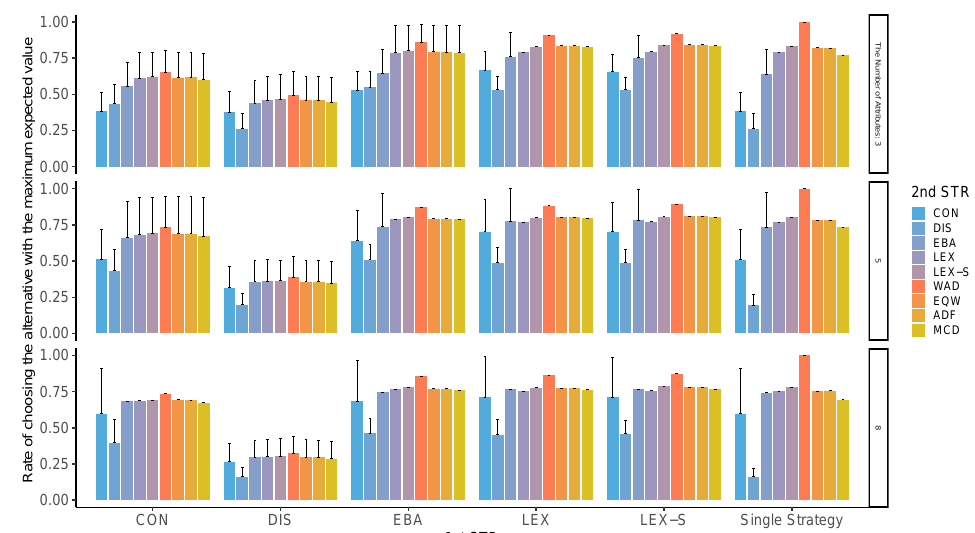
Figure A15. Best-choice rate in two-stage decision-making when only two alternatives are left in the second stage for the different numbers of attributes. ADF: additive difference; CON: conjunctive; DIS: disjunctive; EBA: elimination by aspects; EQW: equal-weighted strategy; LEX: lexicographic; LEX-S: lexicographic semi-order; MCD: majority of confirming dimensions; STR: strategy; WAD: weighted additive.